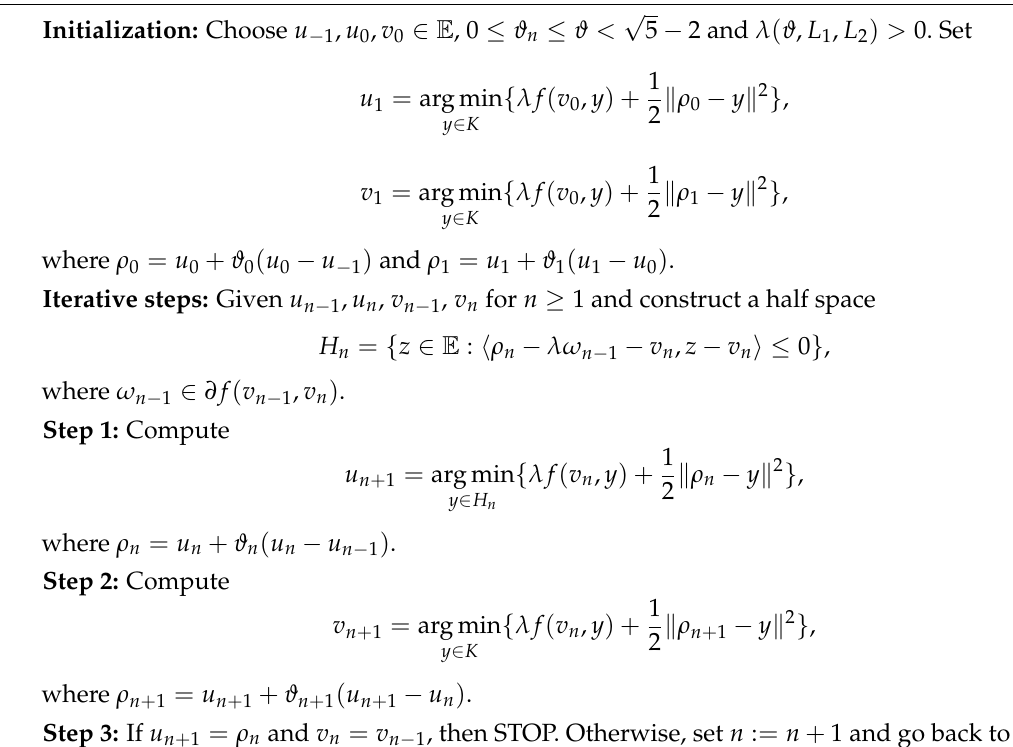
Algorithm 1 (Two-step Subgradient Extragradient Algorithm for Pseudomonotone